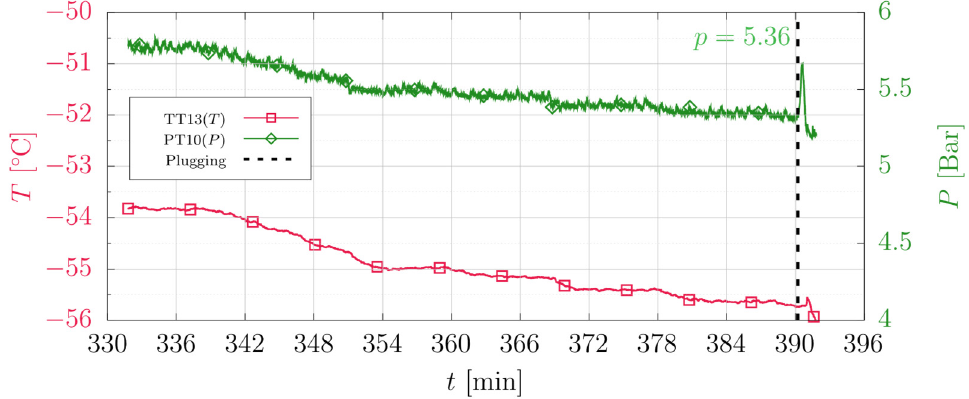
Figure 4. Pressure (PT10) and temperature (TT13) measurements in SV02 during Experiment 2.